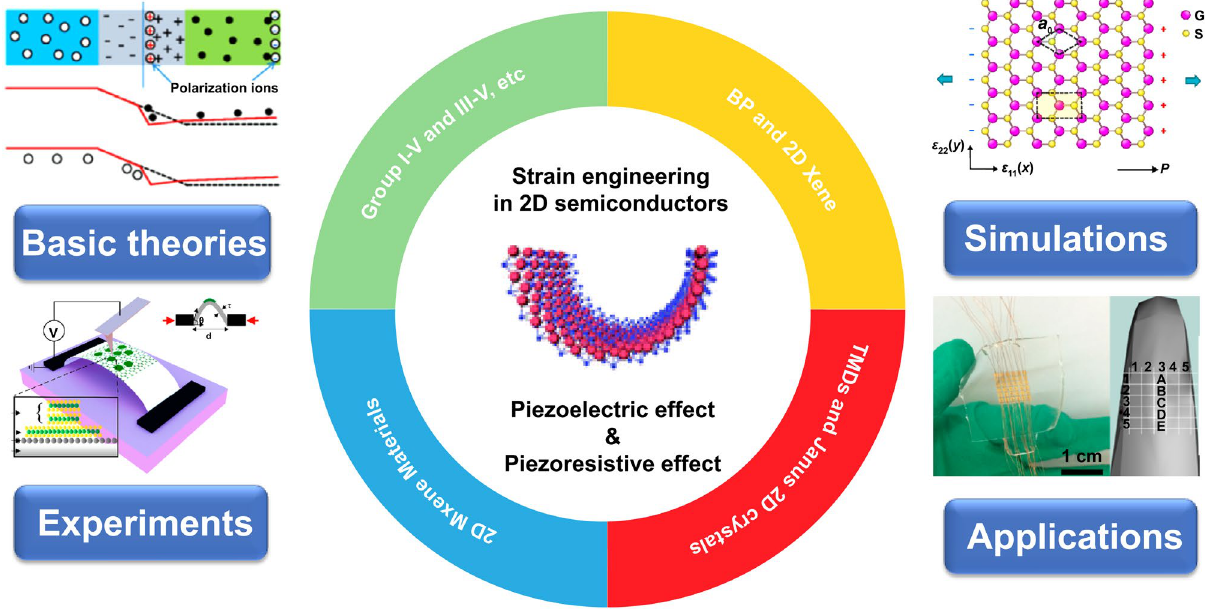
Fig. 1 Strain engineering in 2D materials: from basic theories to applications [81, 200,